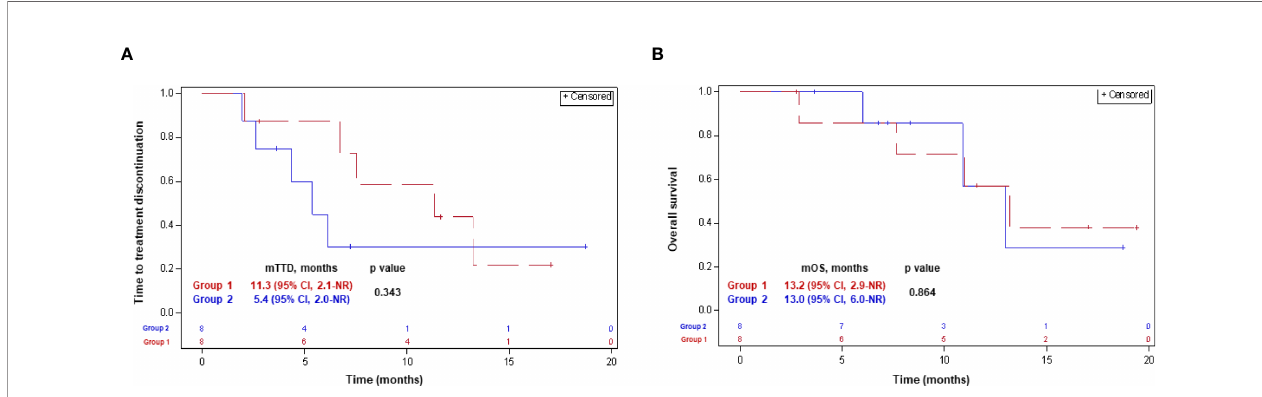
FIGURE 3 | Time-to-treatment discontinuation (A) and overall survival (B) with the NLST in patients in whom the treatment decision was made before (group 2) and after (group 1) getting the CGP results. CGP, comprehensive genomic pro fi ling; CI, con fi dence interval; NLST, next-line systemic treatment; NR, not reached; (m)OS, (median) overall survival; (m)TTD, (median) time-to-treatment